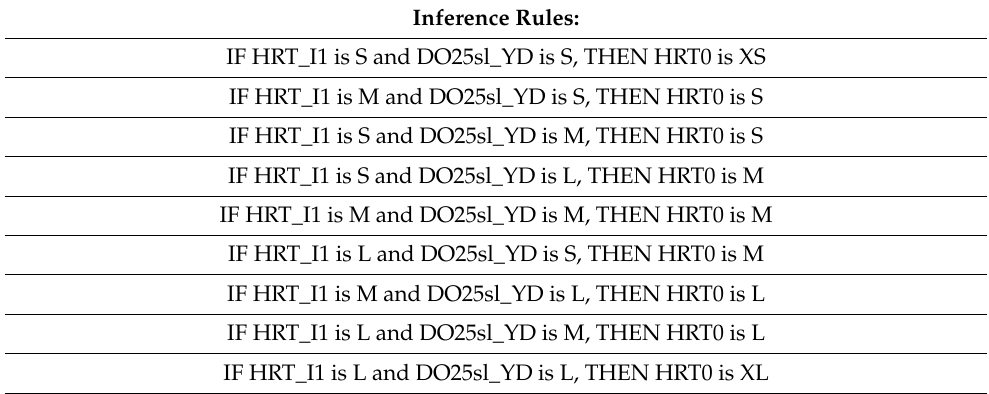
Table 3. Fuzzy control rules HRT0